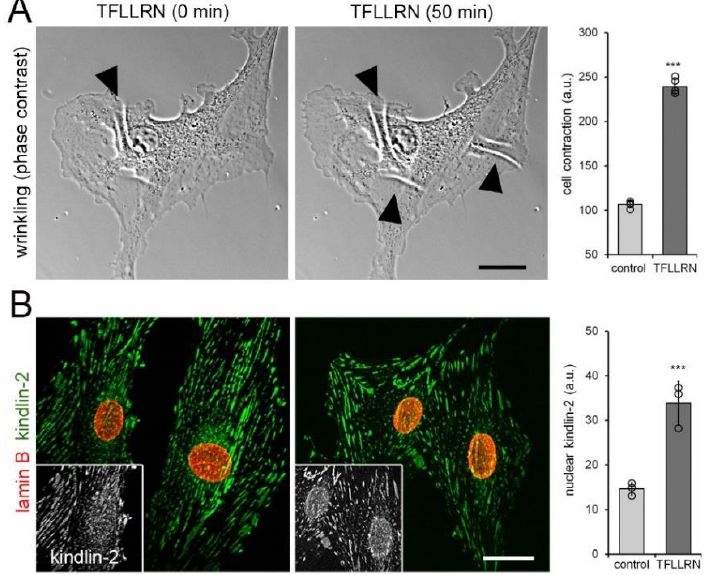
Figure 4. Intracellular force generation leads to kindlin-2 localization to the nucleus. ( A ) Cells grown on “wrinkling” deformable substrates for 8 h were treated with the peptide TFLLRN (20 µ M) to induce cell contraction and phase contrast images were recorded over 50 min. Appearance and increase of substrate folds (white lines, arrowheads) indicate increased cell contraction that was quantified by calculating the image area fraction occupied by wrinkles. ( B ) After 1 h of TFLLRN treatment, cells were immunostained for kindlin-2 (green) and lamin B (red) and confocal images were taken; greyscale insets show kindlin-2. Shown are mean values from at least three independent experiments (data points) ± SD (*** p < 0.001, one sample Student t -test). Scale bars: 15 µm.